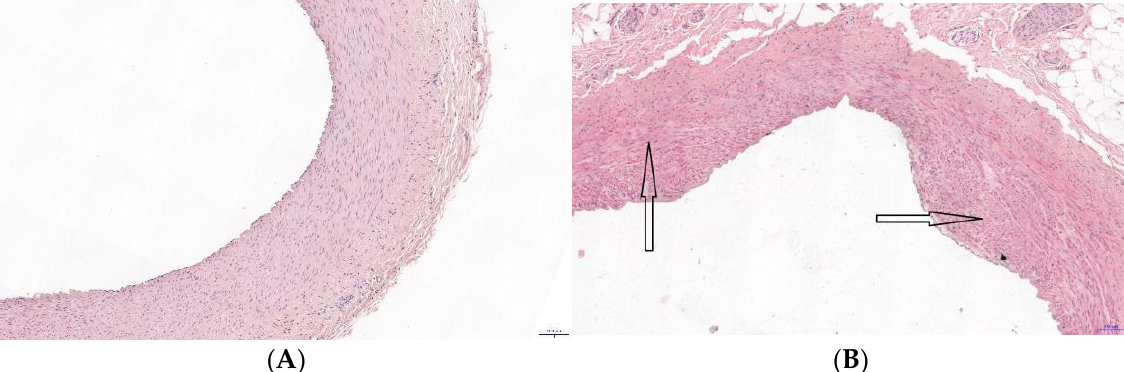
Figure 1. Histopathological examination of left descendens coronary artery. Hematoxylin-eosin staining of samples of heart tissue of swine ( A ) control group, ( B ) arteriosclerotic lesion (black arrow) in a pig with the representative remodeling- group fed a high fat-carbohydrates diet (HF-CD).